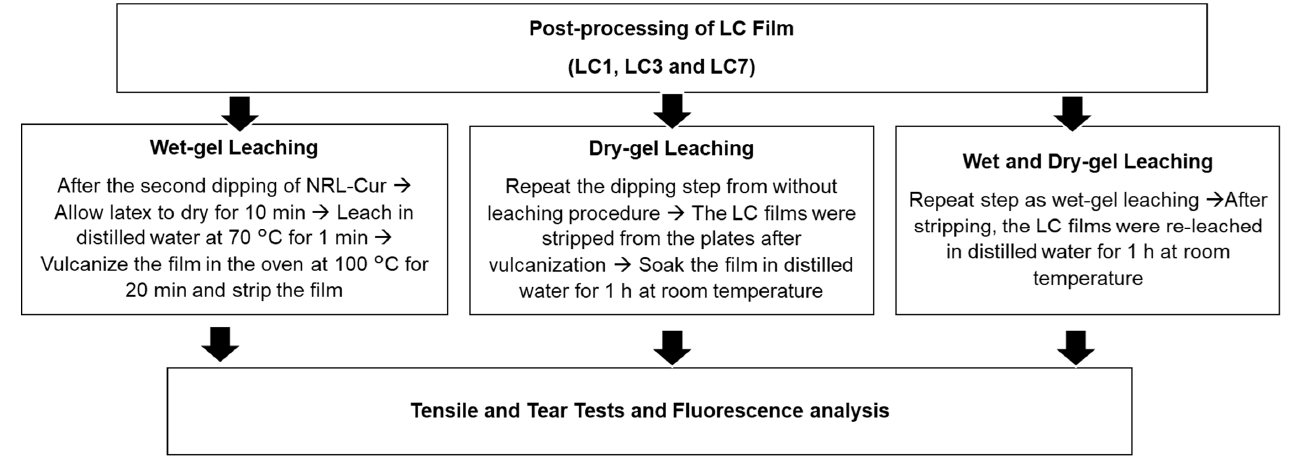
Figure 2. Flow chart of optimised LC films post-processing